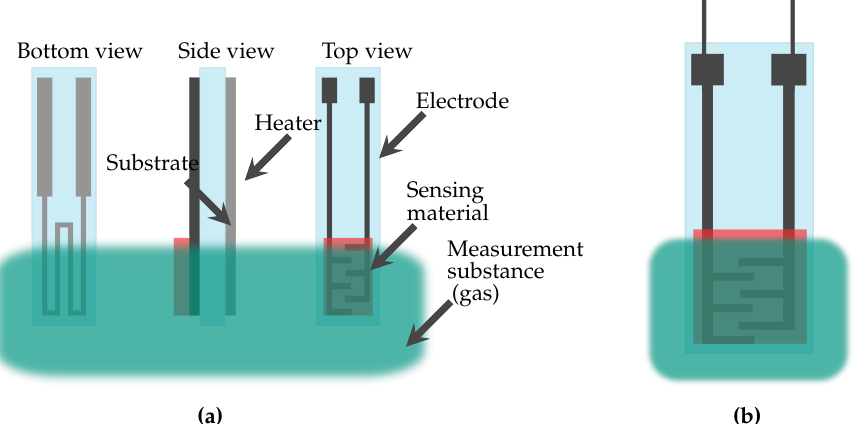
Figure 5. Schematic of an impedimetric sensor. ( a ) The bottom, side, and top views of the impedimetric sensor. ( b ) An expanded view of the sensor. Resistance Ω of the sensing material changes when ozone is present in the measurement